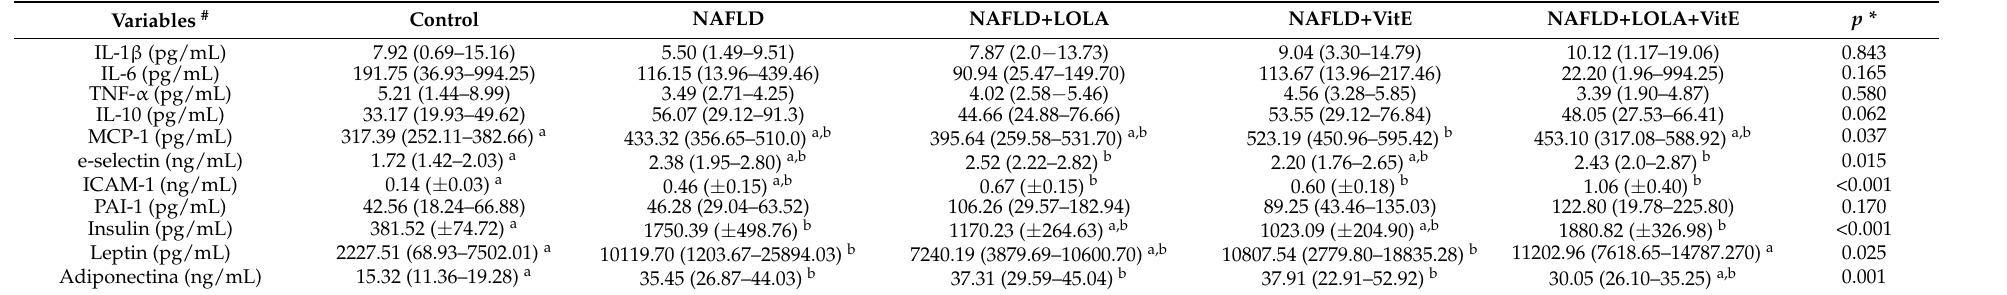
Table 1. Inflammation and endothelial dysfunction in a nutritional model of nonalcoholic fatty liver